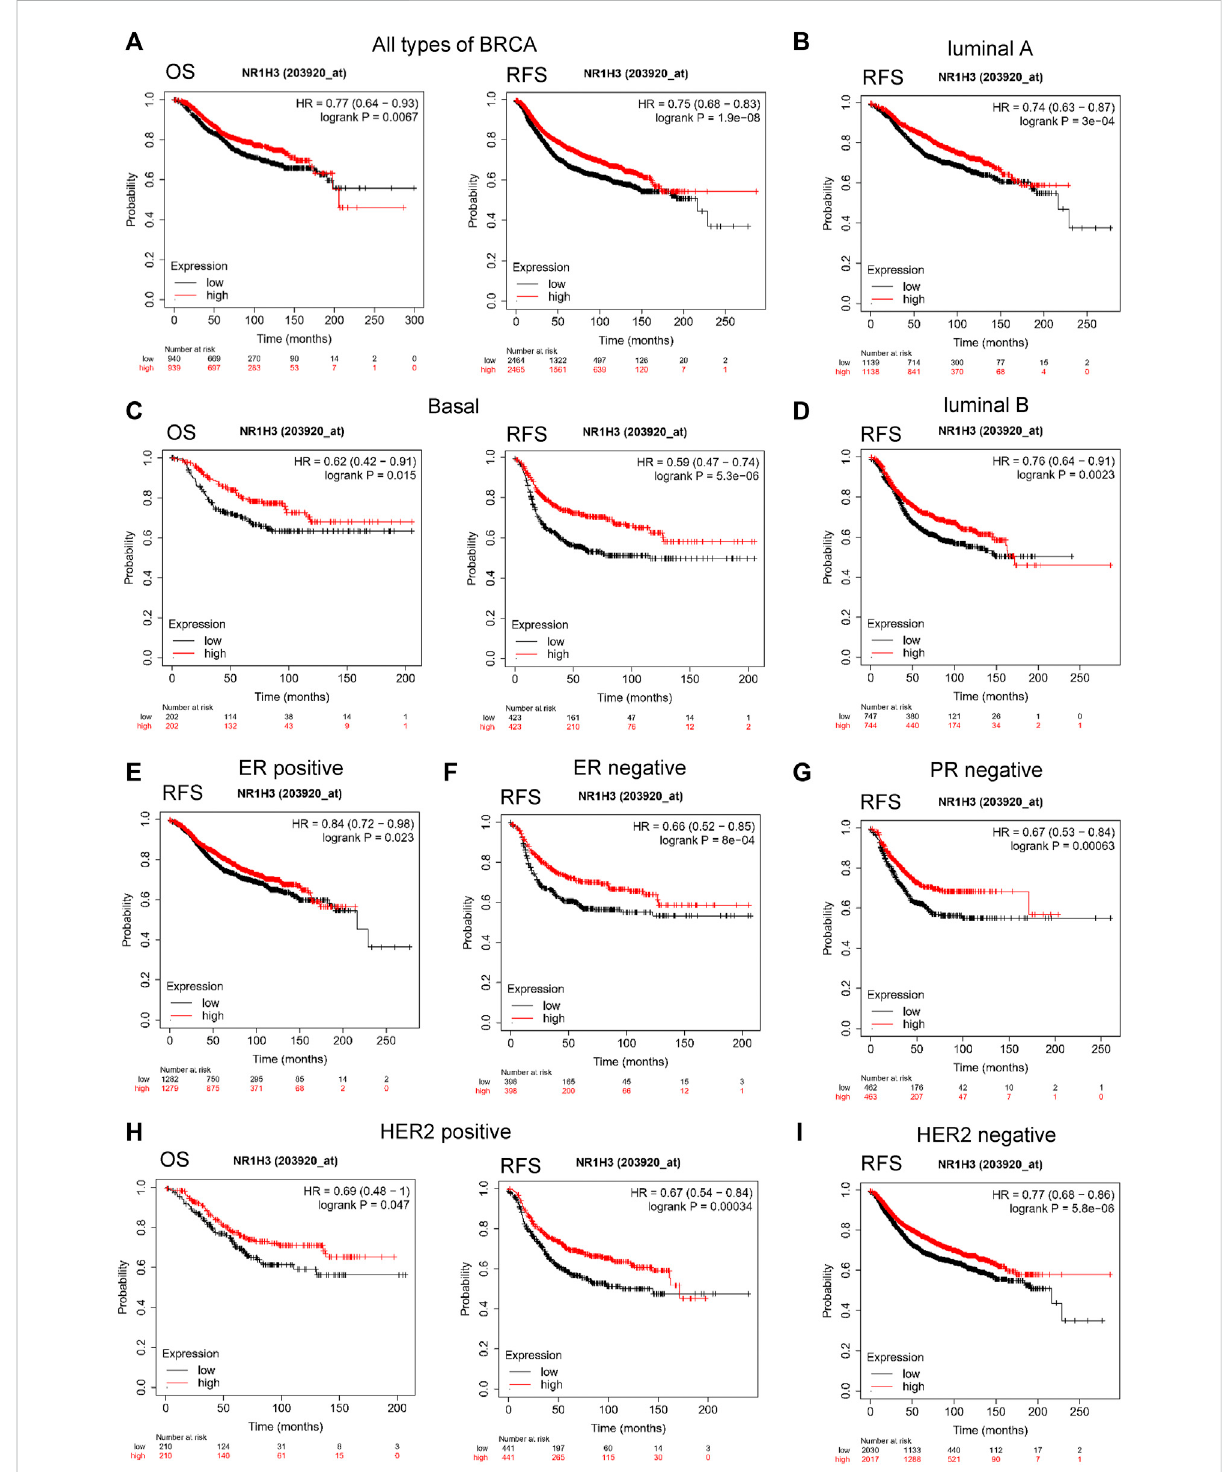
FIGURE 2 Kaplan-Meier survival curves of OS and RFS comparing the high and low expression of NR1H3 in breast cancer. (A) In the Kaplan-Meier plotter database,lowexpressionofNR1H3indicatedaworsesurvivalprognosisofOS,RFSinbreastcancerpatients. (B) RFSsurvivalcurveofluminalAbreast cancer patients. (C) OS and RFS survival curve of basal breast cancer patients. (D) RFS survival curve of luminal B breast cancer patients. (E) RFS survival curve of ER-positive breast cancer patients. (F) RFS survival curve of ER-negative breast cancer patients. (G) RFS survival curve of PR- negativebreastcancerpatients. (H) OSandRFSsurvivalcurvesofHER2-positivebreastcancerpatients. (I) RFSsurvivalcurveofHER2-negativebreast cancer patients. OS, overall survival; RFS, relapse-free survival; ER, estrogen receptor; PR, progesterone receptor; HER-2, human epidermal growth factor